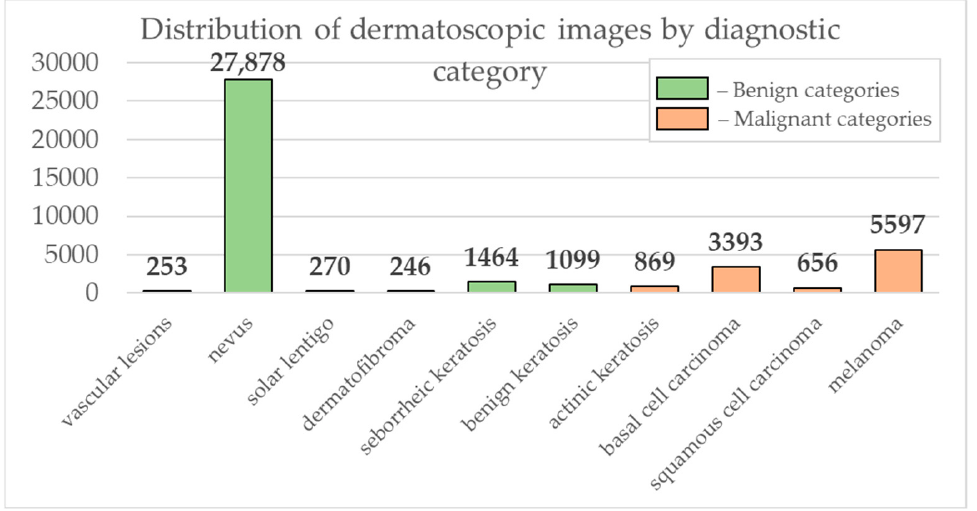
Figure 7. Diagram of the distribution of the number of dermatoscopic images in 10 diagnostically significant categories.